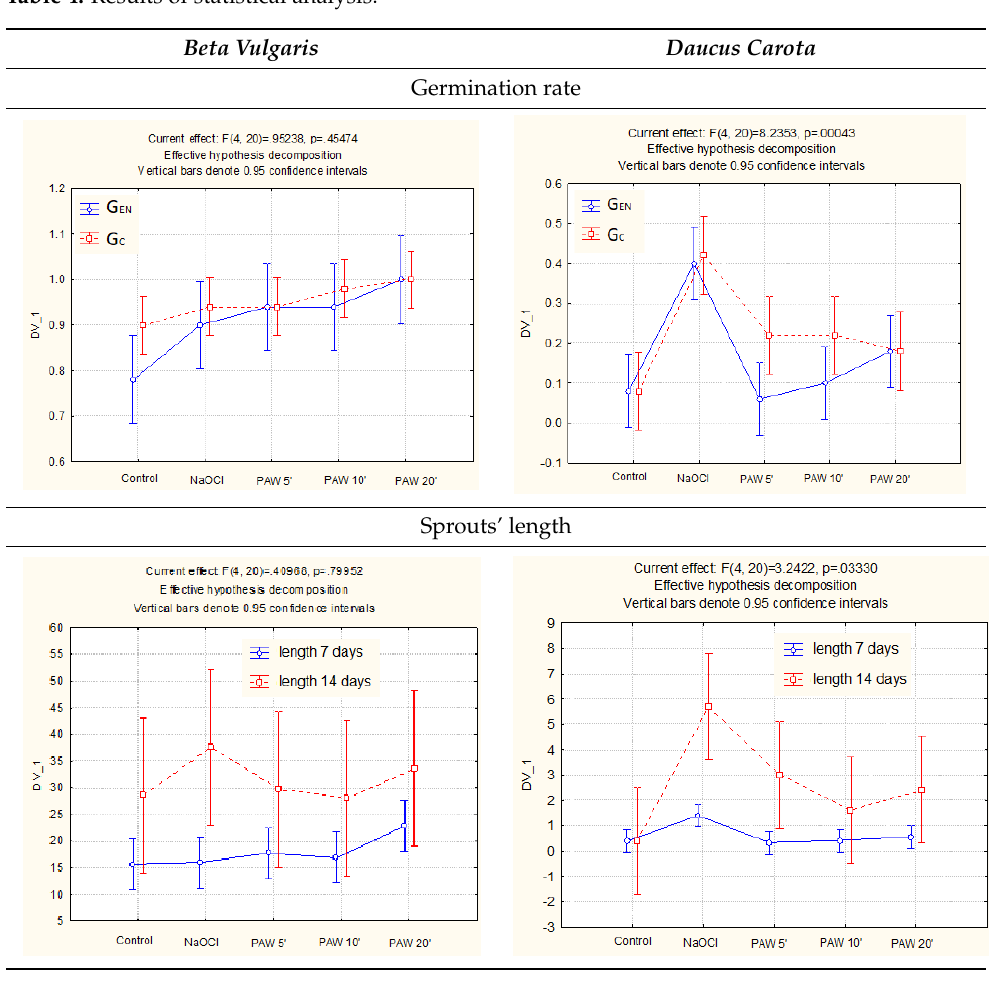
Table 5. Fungal species on Beta